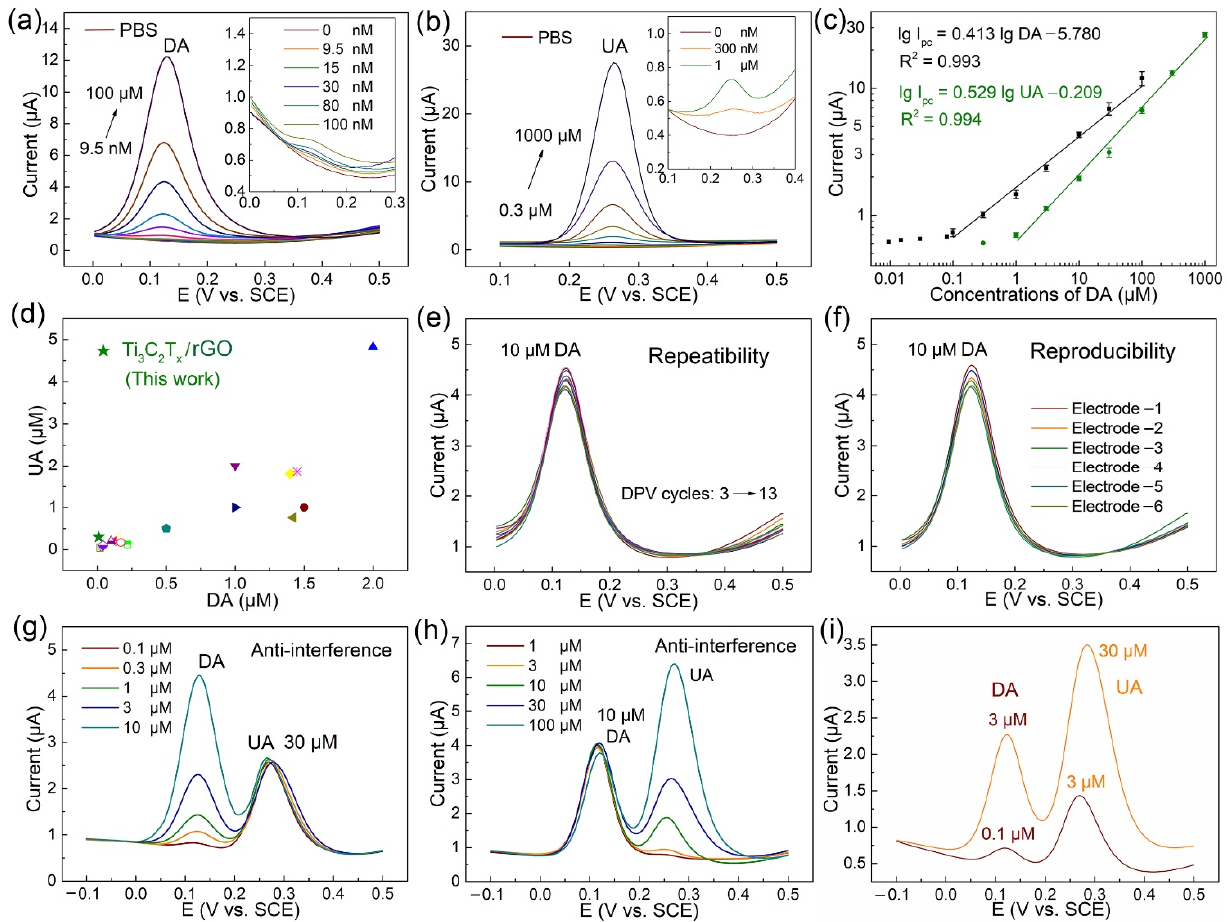
Figure 5. ( a , b ) DPV curves of Ti 3 C 2 T x /rGO electrode with various concentrations of DA and UA; the inset graphic depicts an enlarged view in the potential range between 0.0–0.3 V and 0.1–0.4 V, respectively. ( c ) The corresponding peak current versus DA and UA concentration. ( d ) The performance comparisons. ( e , f ) The repeatability and reproducibility of Ti 3 C 2 T x /rGO electrode. ( g , h ) Good anti-interference of our electrodes. ( i ) Serum sample analysis.